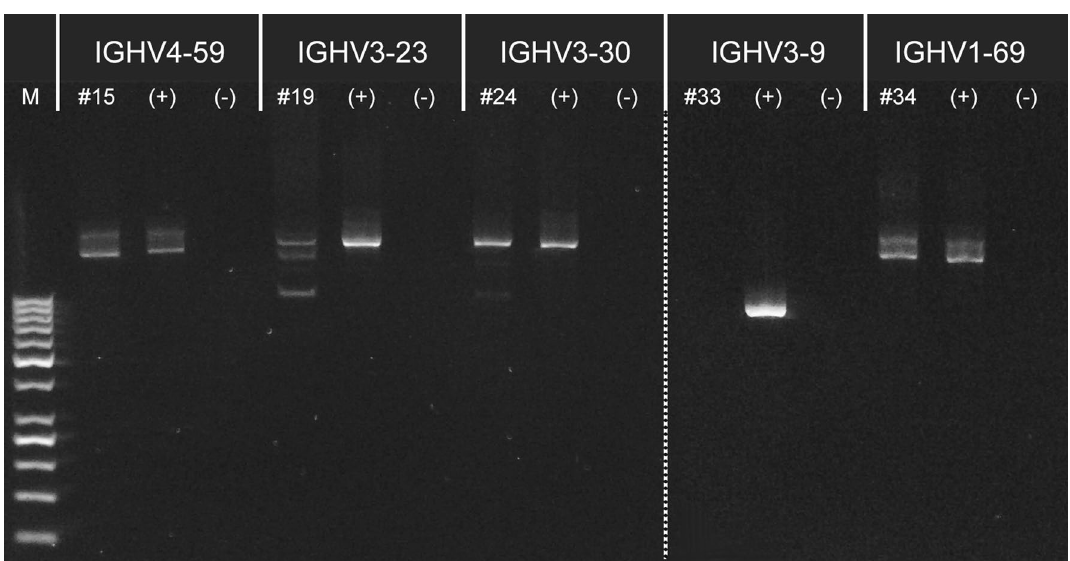
Figure 3. VH specific PCR validation for samples #15, #19, #24, #33 and #34. For each specific VH to be validated, the same PCR is performed on the sample to validate positive (+) and negative (−) controls. Positive controls were samples previously determined for the specific VDJ recombination; instead, negative controls were samples previously tested with different VDJ recombinations. The dotted line delimits two different gels (original images are provided as Supplementary Fig. 4 and Supplementary Fig.